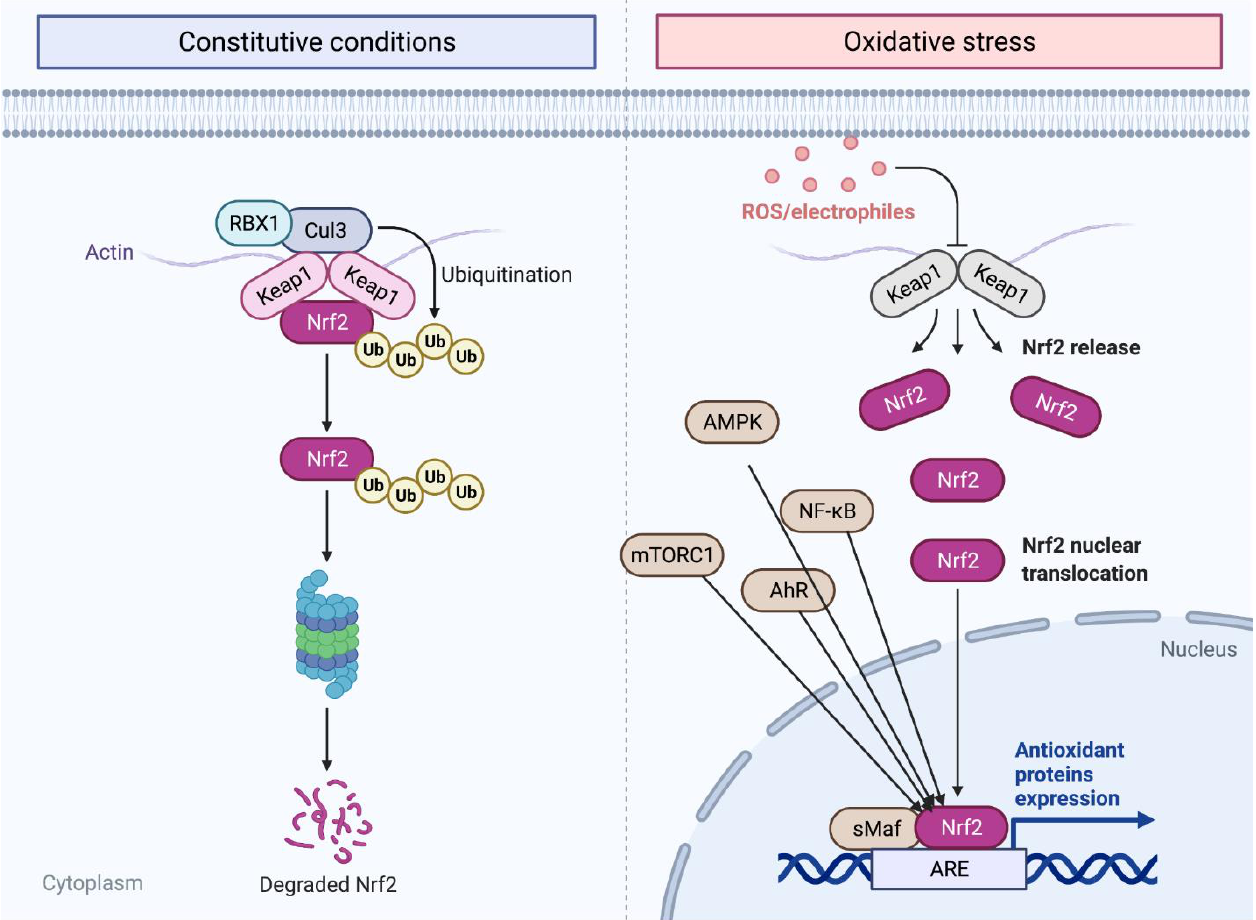
Figure 1. Nrf2 mechanism pathway . Nrf2 is released in the cytoplasm then migrates into the nucleus where it is transcripted during oxidative stress and degraded when it is no longer needed through ubiquitination (see text for more information). The figure was prepared by software provided by Biorender.com (accessed 3 March 2022).